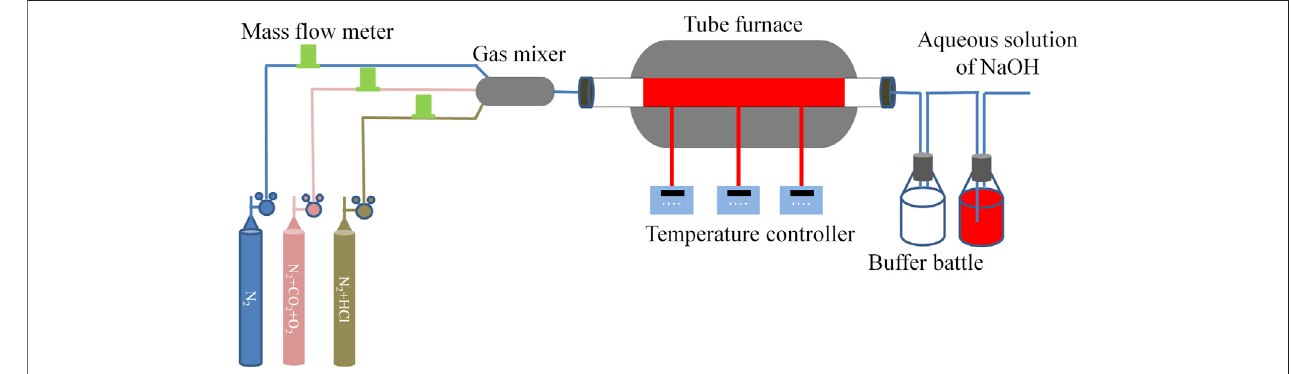
FIGURE 1 | Test device of the high-temperature chloride corrosion.